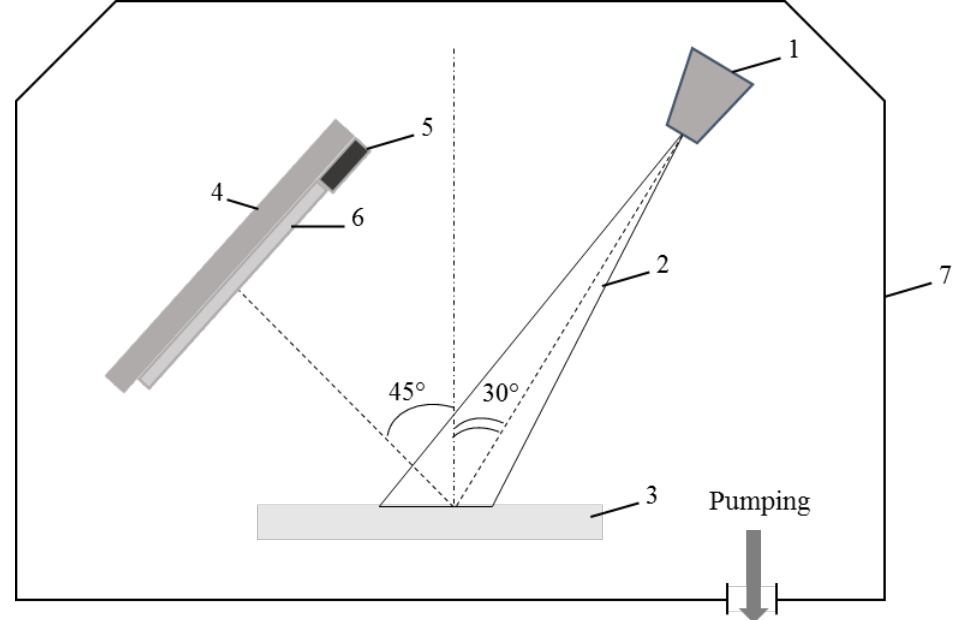
Figure 2. Scheme of low energy electron-beam deposition device: 1—electron gun, 2—electron beam, 3—PTFE target, 4—substrate holder, 5—quartz crystal microbalance device, 6—membrane, 7—vacuum chamber.